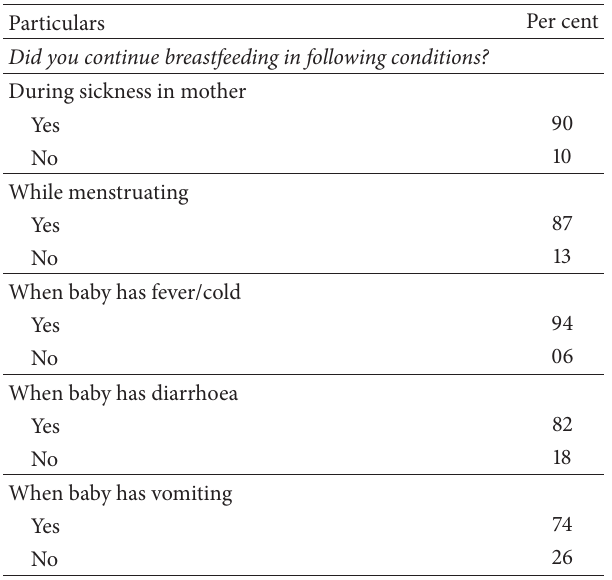
Table 4: Breastfeeding practices in special circumstances by multi- gravida mothers during their previous pregnancy ( 𝑁 = 100 ).